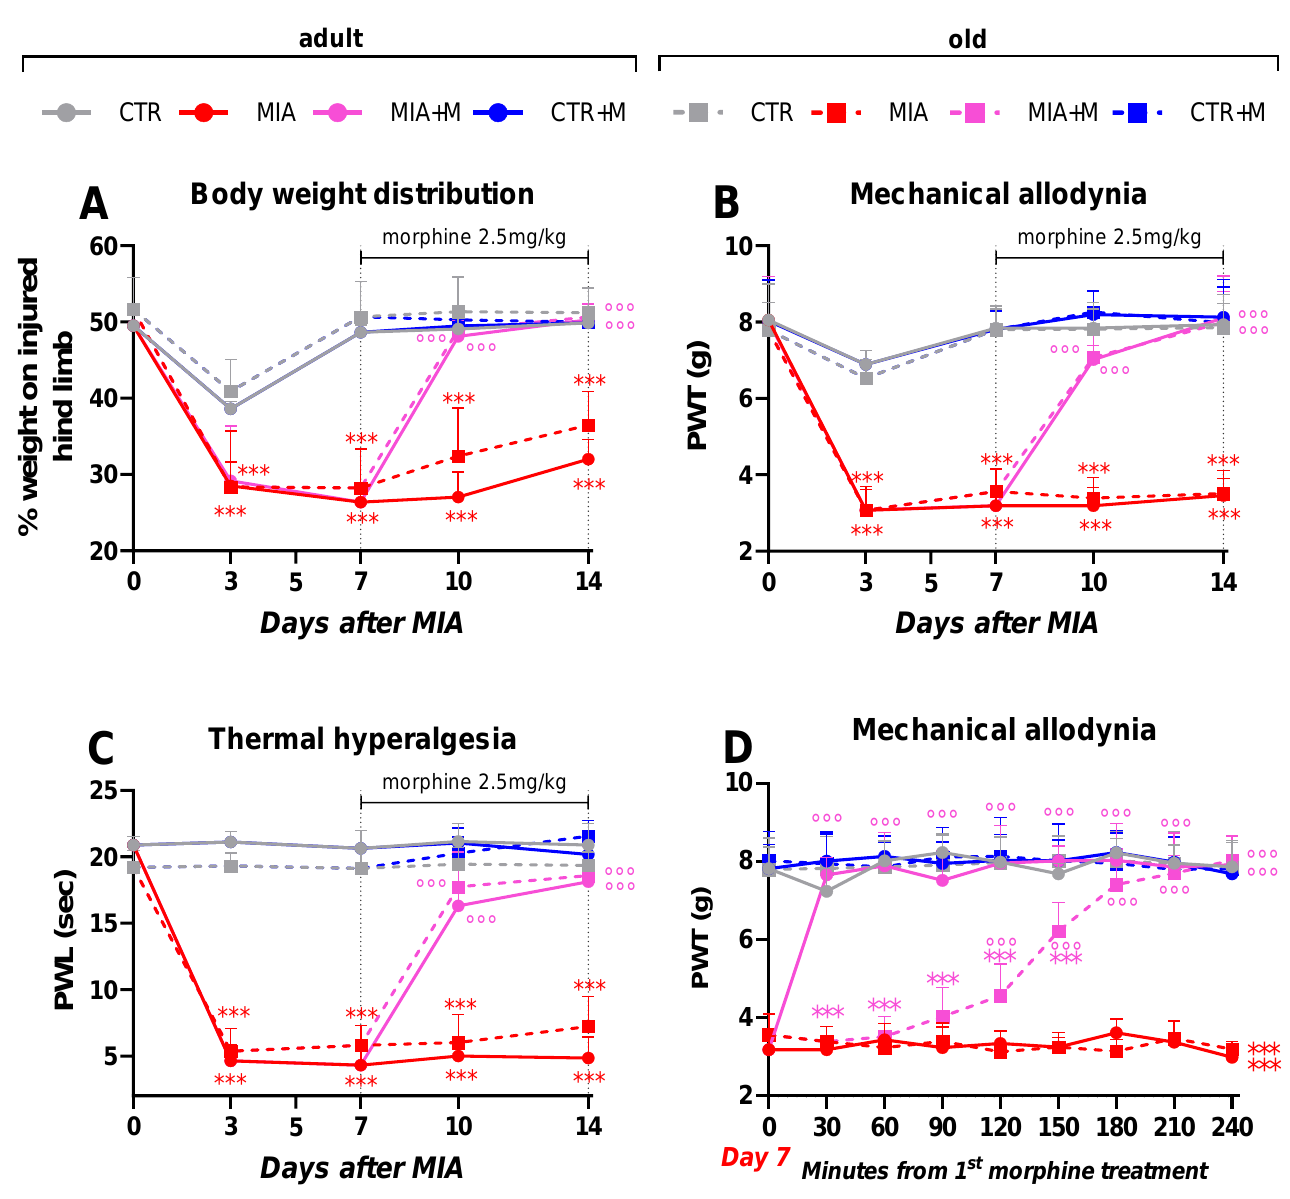
Figure 1. Time course of allodynia and hyperalgesia development. Weight-bearing responses ( A ), mechanical allodynia ( B ), and thermal hyperalgesia ( C ), following MIA intra-articular administration (1 mg in right knee) and morphine treatment (2.5 mg/kg, s.c.) administered once daily for 1-week (from day 7 to day 14) in adult (11-week-old) and old (20-month-old) mice. ( D ) Effect on mechanical allodynia of the first morphine injection (2.5 mg/kg, s.c.) performed on day 7 after OA induction and measured every 30 min up to 240 min. Data represent mean ± SD of 15 mice/group. Statistical analysis was performed by means of two-way ANOVA for repeated measures followed by Bonferroni’s post -test. ( A ) Time × treatments: F (28, 448) = 42.63, p < 0.0001; Time: F (3.533, 395.7) = 448.3, p < 0.001; treatments F (7, 112) = 200.0; p < 0.001. ( B ) Time × treatments: F (28, 448) = 51.23, p < 0.001; time: F (3.043, 340.8) = 353.9, p < 0.001; treatments: F (7, 112) = 319.1, p < 0.001. ( C ) Time × treatments: F (28, 448) = 152.8, p < 0.0001; time: F (2.555, 286.2) = 682.9, p < 0.001; treatments: F (7, 112) = 463.5; p < 0.001. ( D ) Time × treatments: F (56, 896) = 31.73, p < 0.001; time: F (6.894, 772.2) = 48.47, p < 0.001; treatments: F (7, 112) = 1051, p < 0.001. *** p < 0.001 vs. respective age-CTR (intra-articular treated with saline), °°° p < 0.001 vs. respective age-MIA. No significant effect of age was detected during the experimental period since adult and old OA animals always displayed similar pain-like behavior. In the contralateral paw, no changes were ever found with respect to the basal thresholds (data not shown). Seven